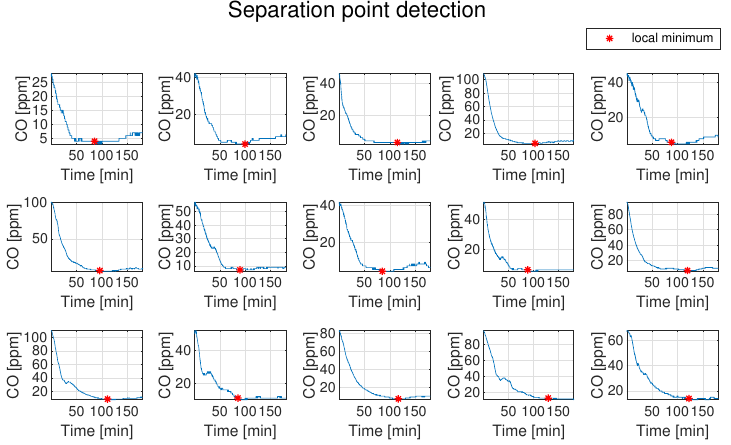
Figure A4. The detection of the separation point—Part I.